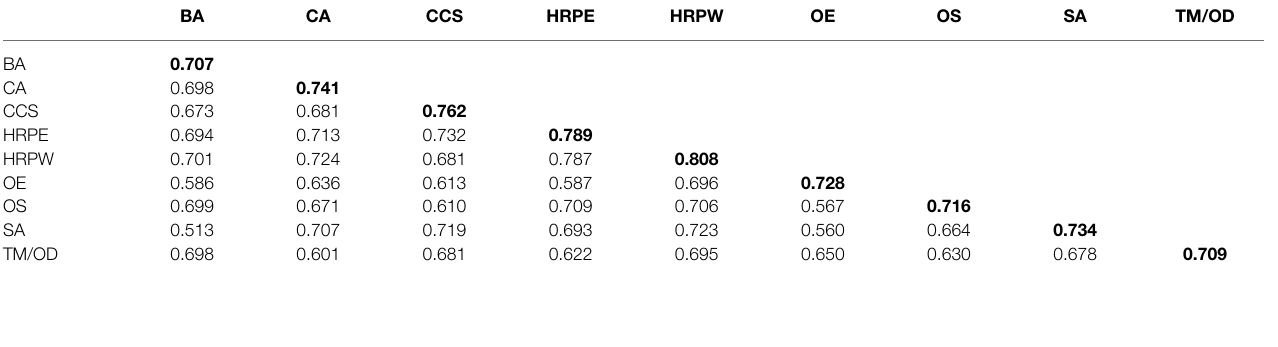
TABLE 2 | Discriminant